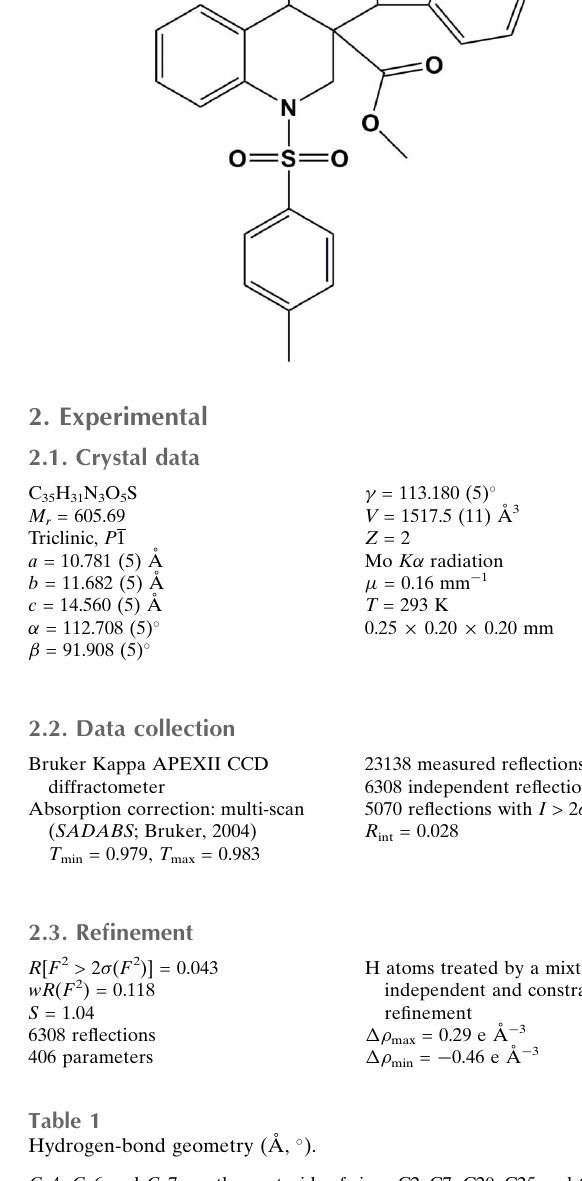
Hydrogen-bond geometry (A˚ , (cid:2)